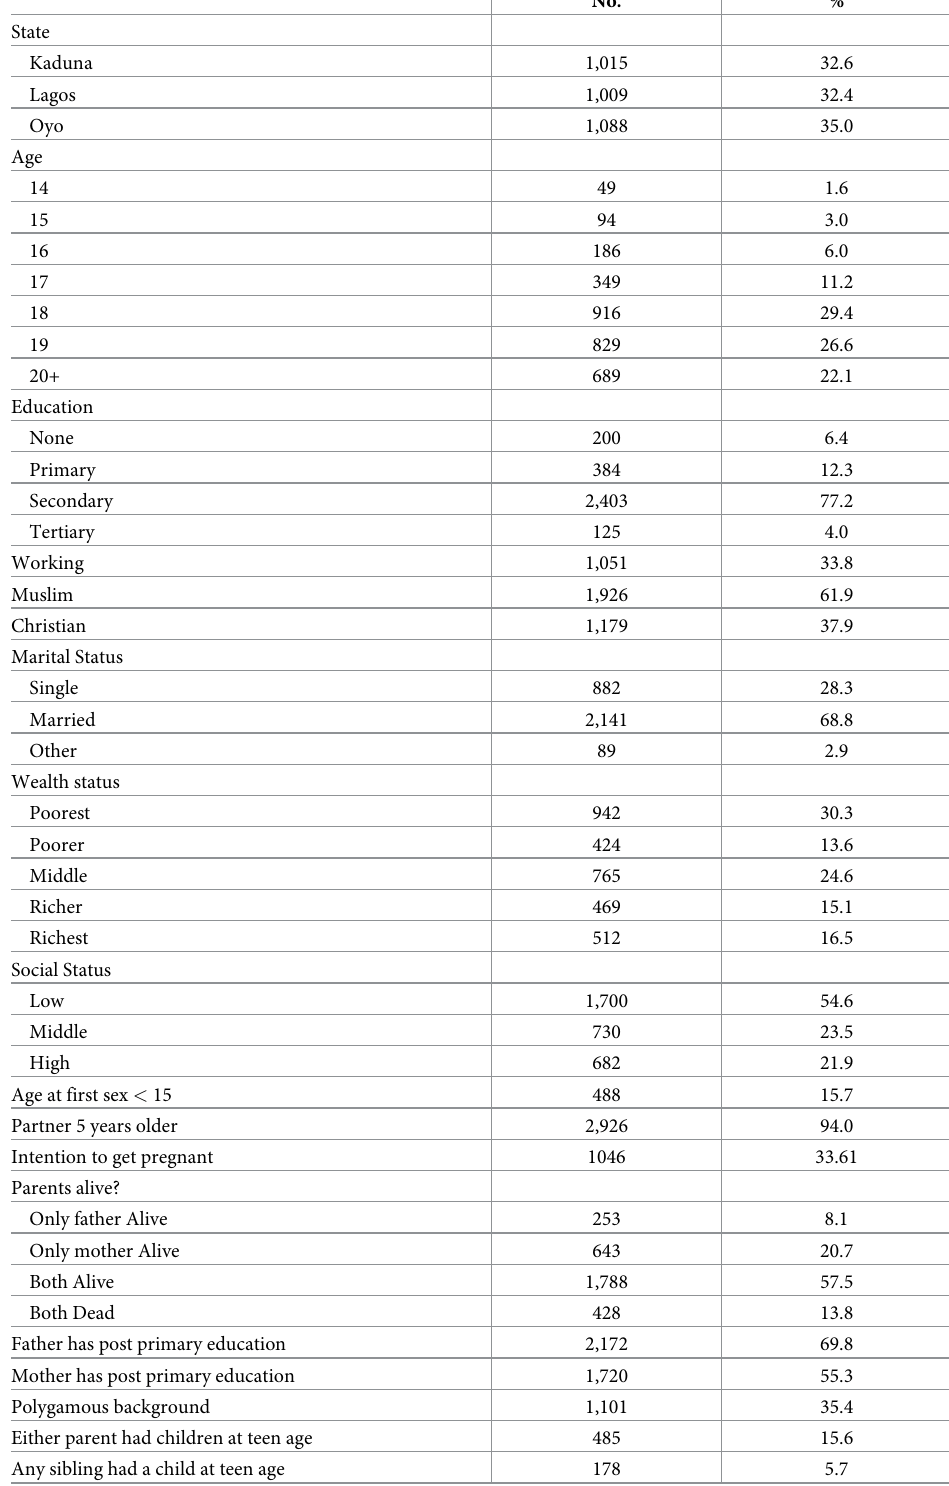
Table 1. Percentage distribution of respondents, by background